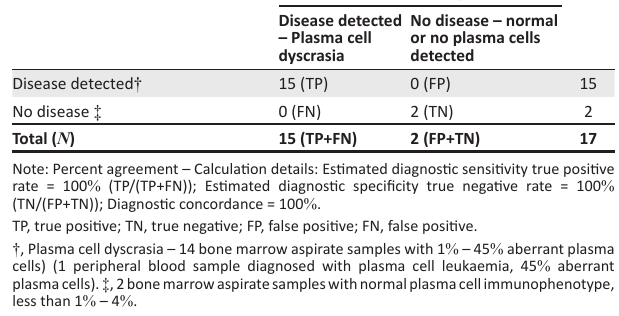
TABLE 5: Comparison of predicate reagents and DURAClone RE PC reagent during assessment of normal and abnormal plasma cell populations undertaken at the Charlotte Maxeke Johannesburg Academic Hospital flow cytometry laboratory in Johannesburg, South Africa, April 2020 to August 2020. Text method: DURAClone RE PC Predicate method: ClearLLab 10C and second-line in-house